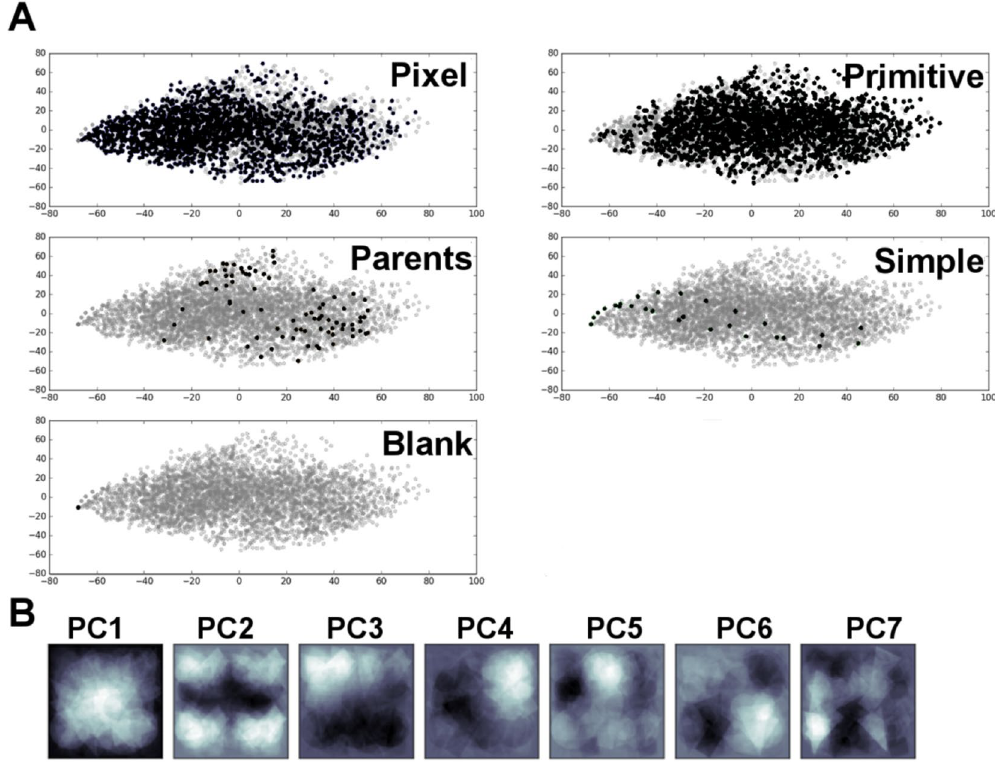
Figure 6. Principal Component Analysis of GTopoChip1. ( A ) Scatterplot that represents every surface in first 2 Principal Components, split by groups. ( B ) Image reconstruction of first 7 Principal components. White colour corresponds to highest